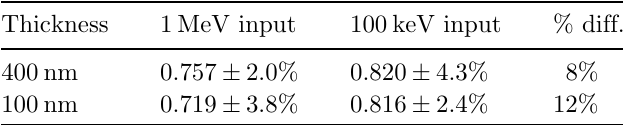
Table 4. Effect of gate oxide thickness and input spectra thresholds on the RadFET dose response: simulated dose